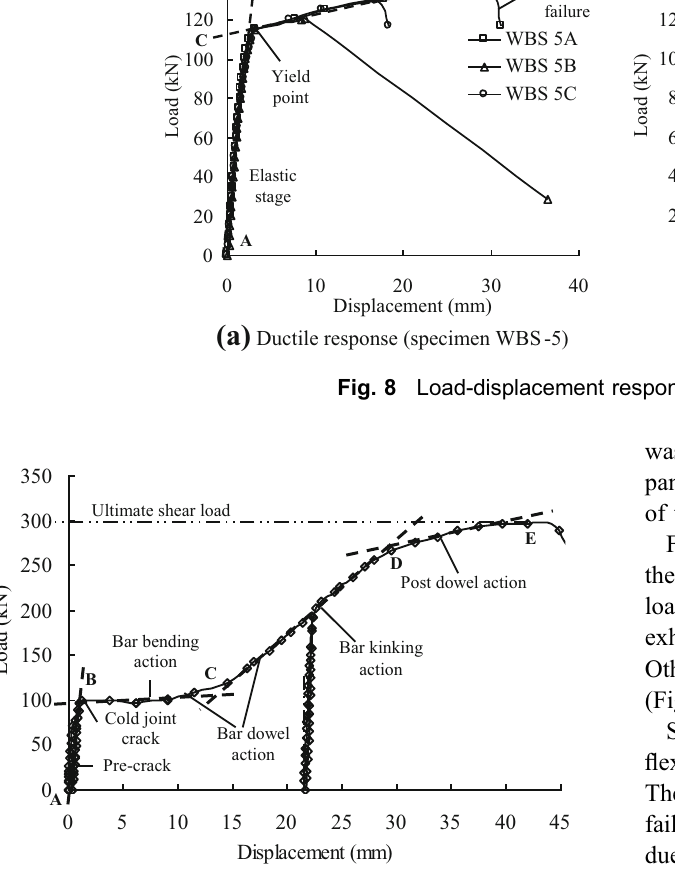
Fig. 9 Load-displacement response of wall assembly under shear load (specimen WBS-8).